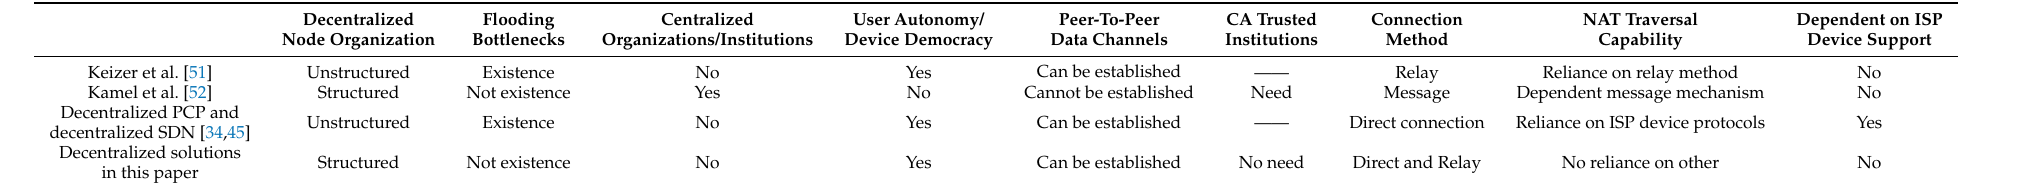
Table 4. A comparison of four types of decentralized